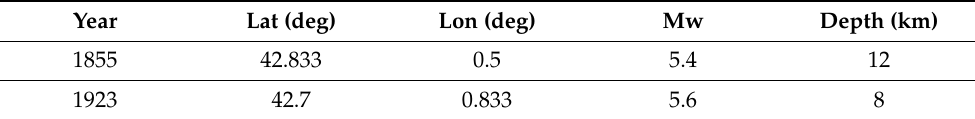
Table 6. Parameters of the 1855 and 1923 historical earthquakes that affected the region of Luchon, from the FCAT-17 parametric catalog [71].